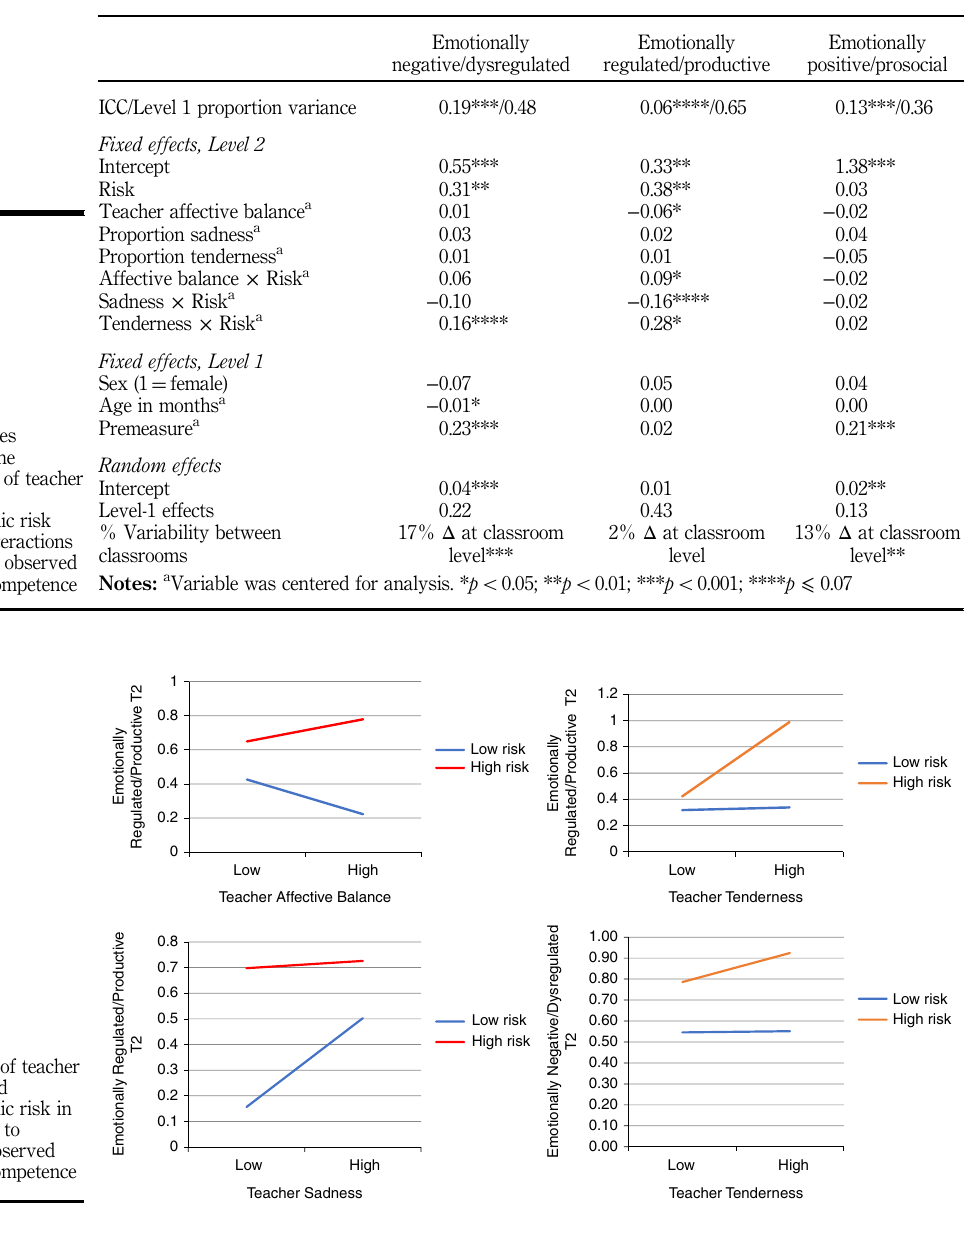
happiness), as well as more nonsupportive behavioral reactions and more positive emotional responsiveness for children in high-risk classrooms (see Table III and Figure 3).